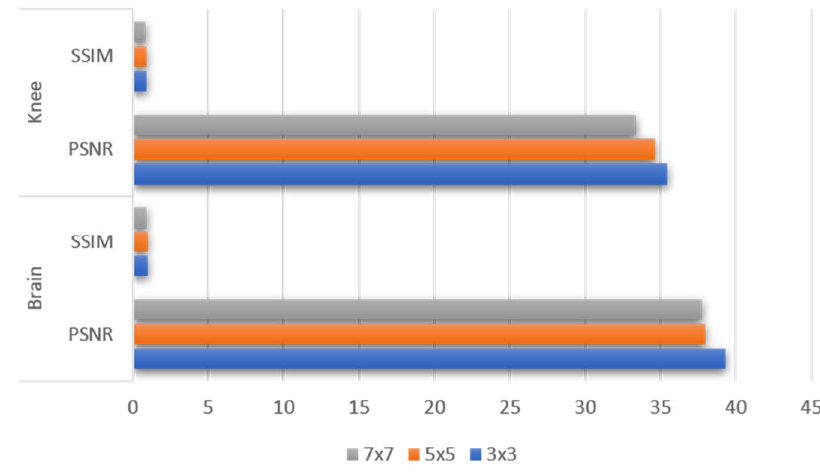
Figure 6. The graph of the PSNR/SSIM values obtained as a result of experiments by using different filter size (3 × 3, 5 × 5 and 7 × 7) on our private brain and public dataset. The model produced excellent reconstruction results (PSNR, 37.98; SSIM, 0.97). Then, us-